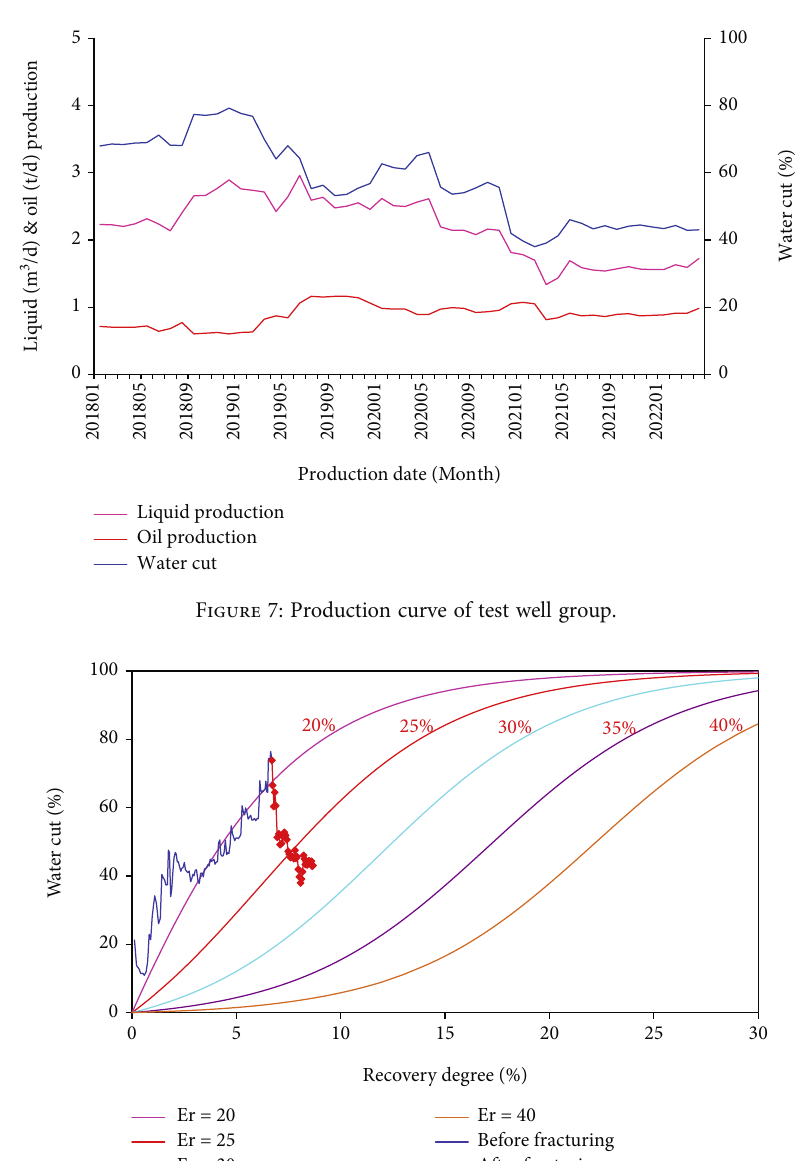
Figure 8: Curve of recovery degree-water cut of test well group.